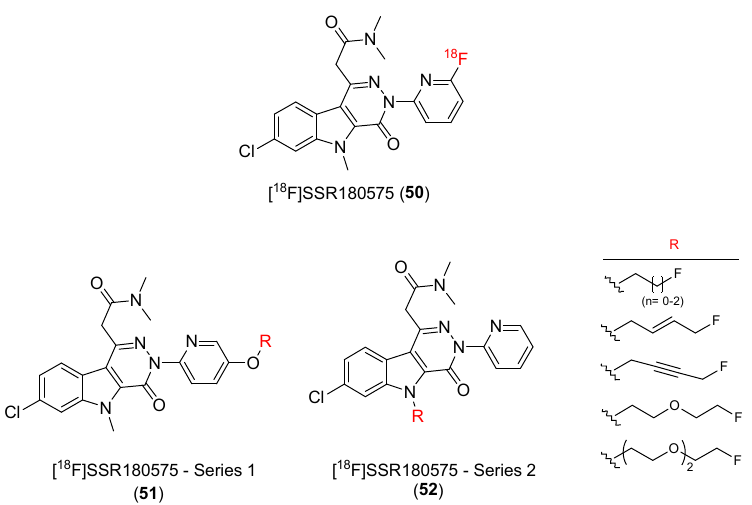
Figure 7. Structures of TSPO ligands containing pyridazinoindole. Manning and co-workers developed 7-chloro-N,N-5-trimethyl-4-oxo-3(6-[ 18 F]fluoropyridin-2-yl)-3,5-dihydro-4H-pyridazino [4,5-b]indole-1-acetamide, or [ 18 F]SSR180575 ( 50 ), as a potential TSPO ligand [106]. Using ethyl 6-chloroindoline-2-carboxylate as a starting material,